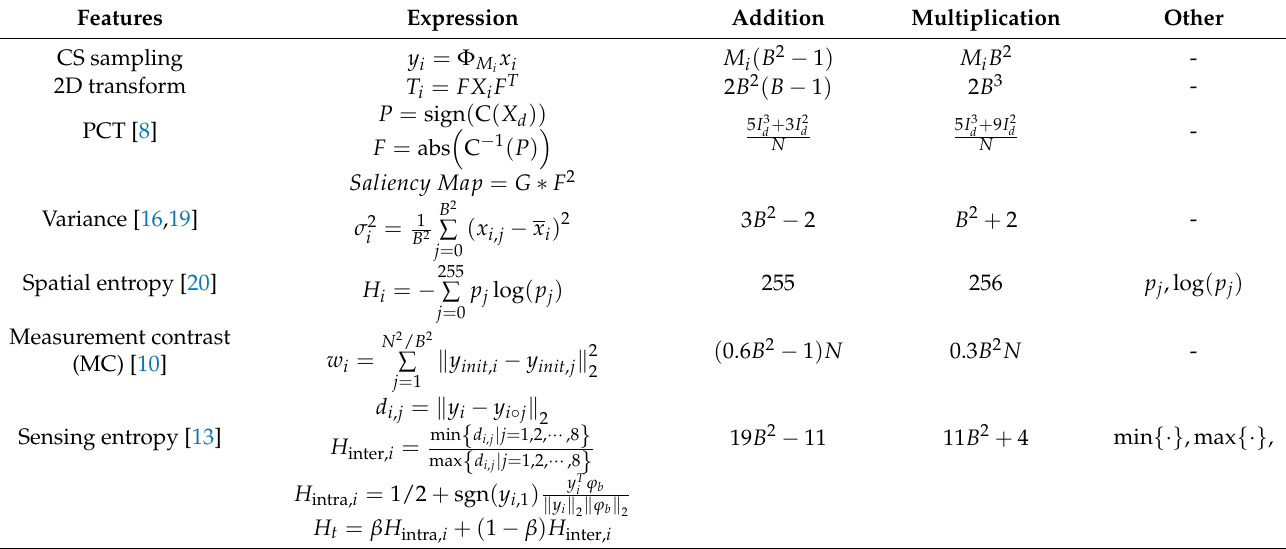
Table 1. The number of operations required for different